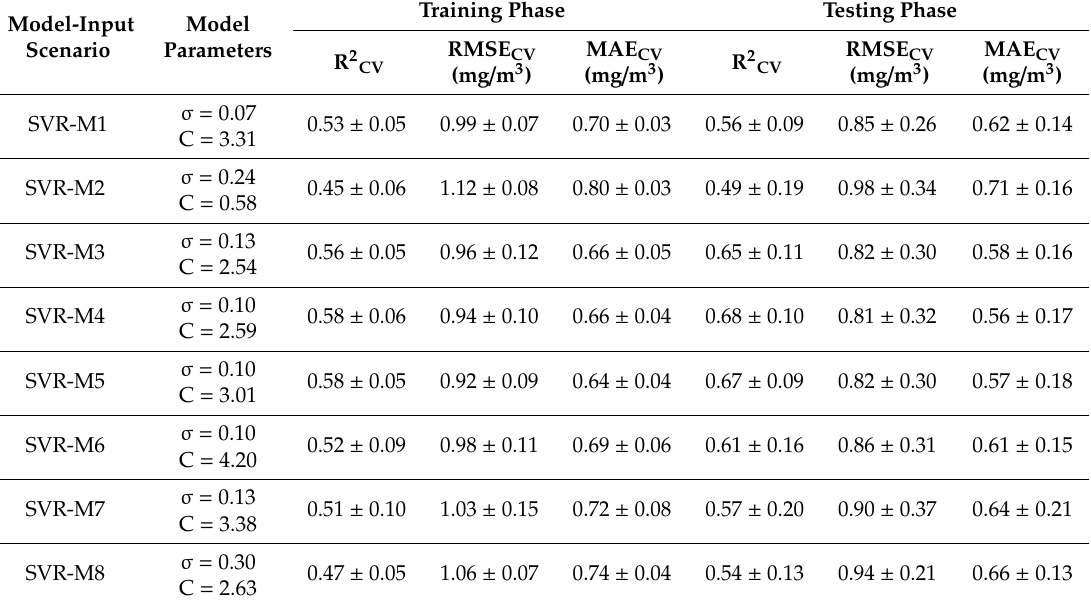
Table 5. Performance of Chl-a estimation from SVR models based on eight di ff erent input scenarios obtained in 5–fold cross